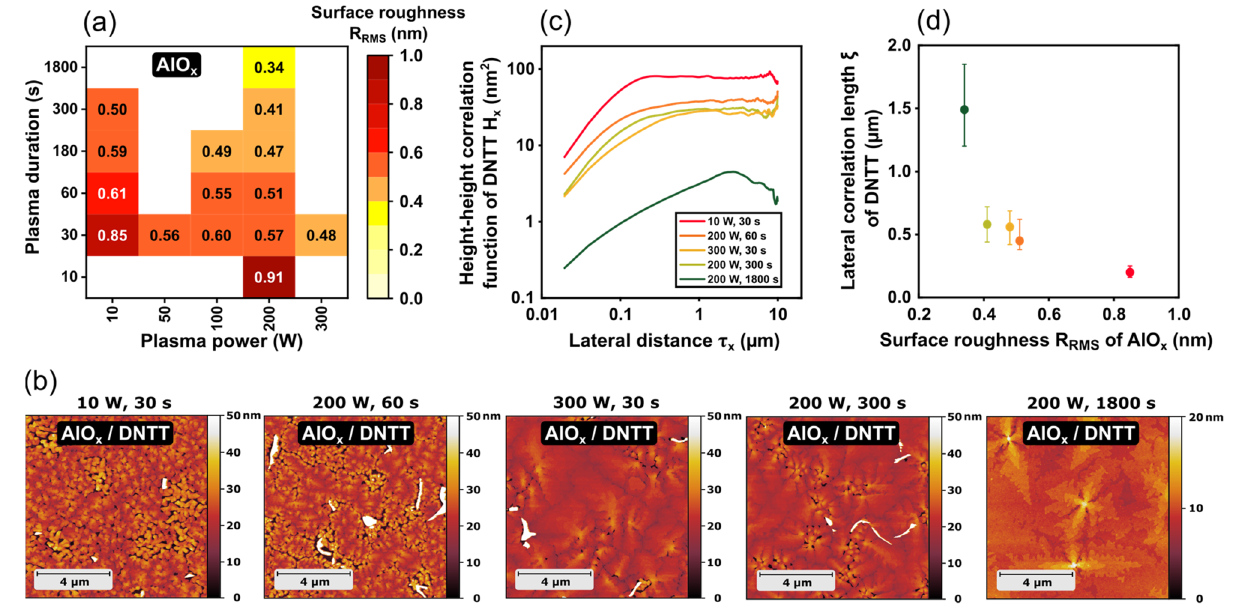
Figure 7. ( a ) Root-mean-square surface roughness of bare-AlO x dielectrics as a function of plasma power and plasma duration. ( b ) AFM images of DNTT films deposited onto bare-AlO x dielectrics for five combinations of plasma power and plasma duration. ( c ) Height-height correlation functions (HHCF) of DNTT films deposited onto bare-AlO x dielectrics for the same five combinations of plasma power and plasma duration. ( d ) Lateral correlation length ξ of the DNTT films as a function of the surface roughness of the bare-AlO x